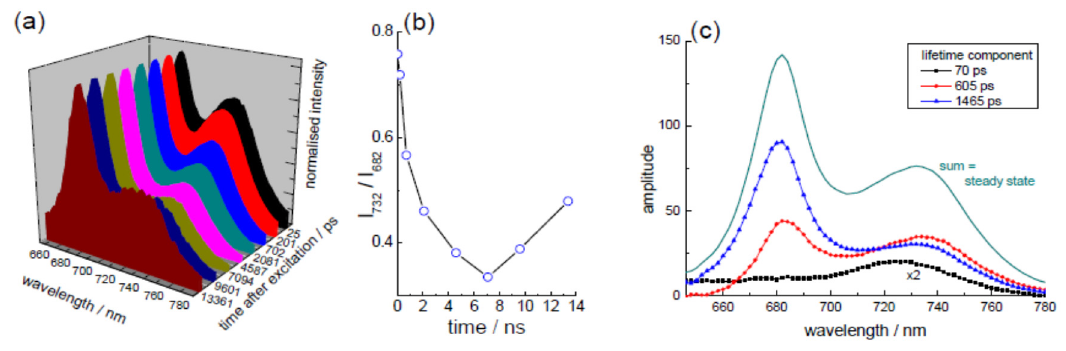
Figure 3. TRES measurement performed on a whole leaf ( Ficus ), showing ( a ) time-resolved emission spectra; ( b ) change in peak ratio of the principal emission bands with time after excitation and ( c ) decay associated spectra obtained via a global analysis of the TRES dataset. Adapted from